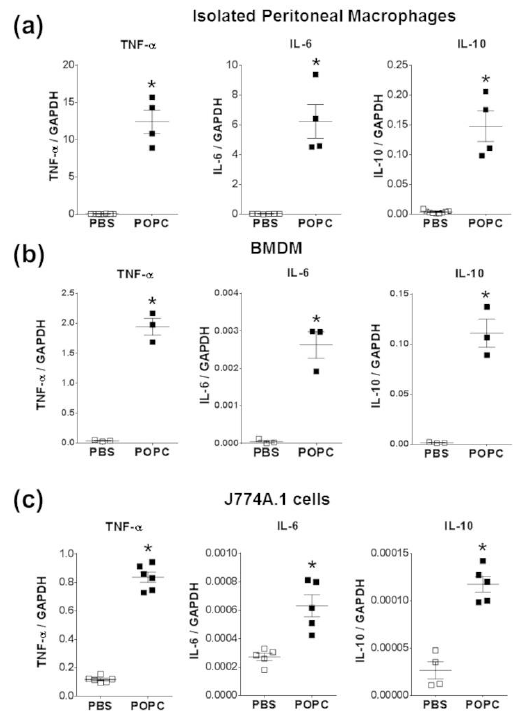
Figure 7. POPC liposomes trigger an inflammatory response in macrophages. ( a ) Resident naïve peritoneal macrophages were obtained from peritoneal cavity lavage as described in the Materials and Methods section. Briefly, peritoneal cells were allowed to attach for 1 h at 37 °C in a CO 2 incubator. Non-adherent cells were removed, and fresh medium was added. Cells were then incubated for an additional 16 h, and the presence of macrophage markers CD11b and F4/80 was evaluated by flow cytometry. ( b ) Bone marrow-derived macrophages (M ϕ ) were obtained from the femur and tibia of male CD-1 mice (9 weeks old). After isolation, bone marrow cells were depleted of red blood cells and resuspended (2 × 10 6 cells/mL) in a culture medium supplemented with 10 ng/mL recombinant M-CSF. The culture medium was changed after 3 days, and non-adherent cells were discarded. The presence of mature bone marrow-derived M ϕ was evaluated by expression of CD11b and F4/80 and stimulated on day 7. ( c ) The macrophage cell line J774A.1 was obtained from ATCC and maintained in RPMI1640 with L-glutamine and penicillin/streptomycin and supplemented with 10% FBS. All macrophage types were exposed to POPC liposomes (2 × 10 5 liposomes per cell) for 1 h. Levels of TNF- α, IL -6, and IL-10 mRNA were determined by qPCR with the housekeeping gene GAPDH used to normalize data to cDNA inputs. Results are expressed as means ± SEM, and statis- tical analysis for the comparison between groups was performed using unpaired Student’s t -test with * indicating p < 0.05.